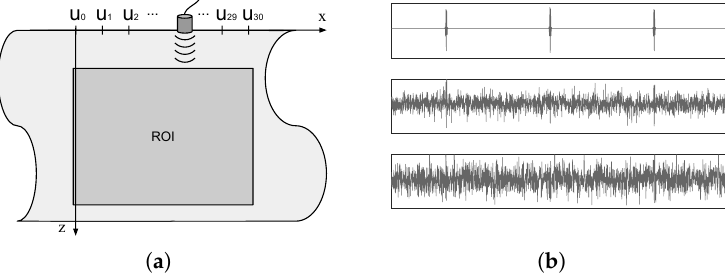
Figure 5. ( a ) simulated set (figure adapted from [21]). The transducer, fixed vertically at z = 0, slides horizontally over the surface of the interrogated object, acquiring scanlines at 31 positions x = { u 0 , . . . , u 30 } , corresponding to 0 mm up to 31 mm with 1 mm step. The scanlines are concatenated to form the acquired vector c . A PSF y ( x , z ) is determined by placing a unity amplitude scatterer on position ( x , z ) and acquiring the corresponding c ; ( b ) extracts from the acquired data for the three centermost transducer positions, with a unity amplitude scatterer located at the center of the ROI. White Gaussian noise was added with σ = 0 (up), σ = 0.08 (middle) and σ = 0.12